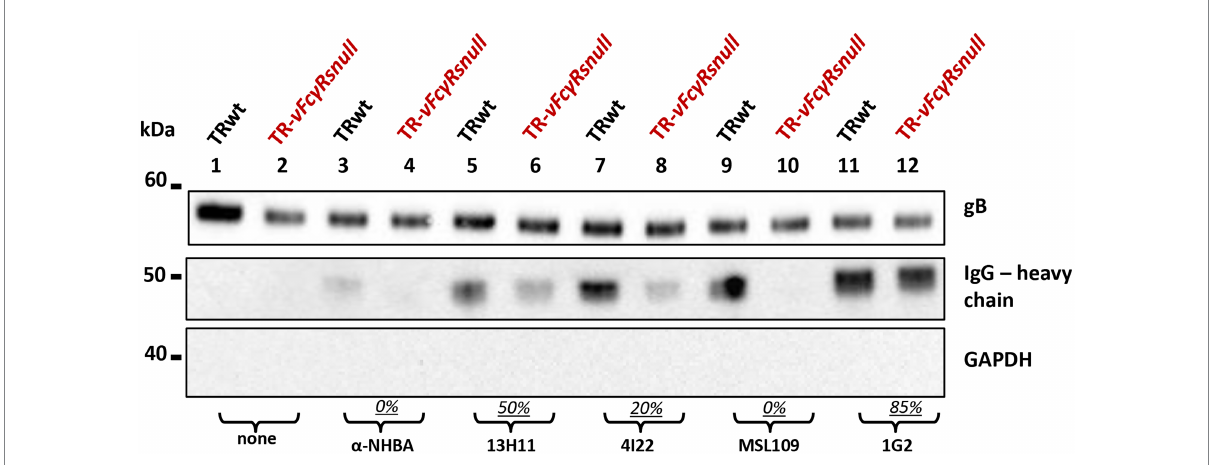
FIGURE 6 Monoclonal anti HCMV glycoproteins are transported on virions by vFc γ Rs dependent and independent mechanisms. HFF-1 cells were infected with HCMV TR-wt or TR- vFcRnull . At day 2 p.i., human monoclonal antibodies (indicated at the bottom of the figure) were added to the culture media. After incubation at 37 ° C for 48 h, cells were washed and incubated with fresh medium for additional 48 h. Pelleted viruses were treated with SDS-PAGE and western blot analysis. Human IgG heavy chains (middle panel) were revealed with HRP-conjugated anti-human IgG antibody. Anti- gB (upper panel) and anti-GAPDH (bottom panel) were used as viral protein marker and to exclude cellular contaminations,